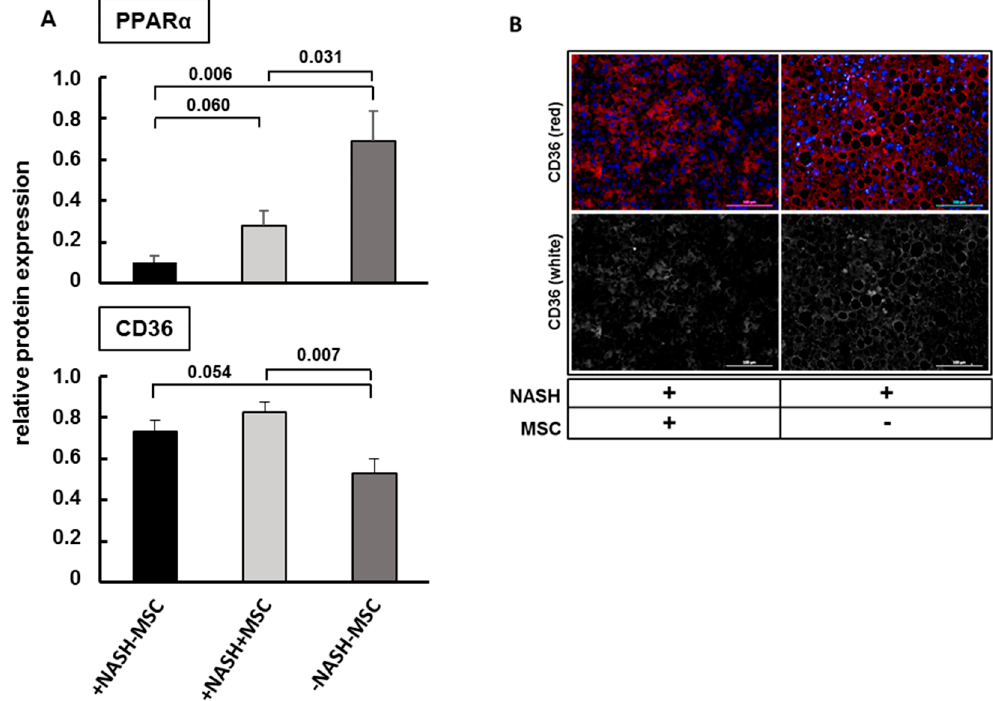
Figure 2. Expression of CD36 and PPAR α in MCD-treated mice with and without MSC application. ( A ) Upregulation of CD36 expression and downregulation of PPAR α in NASH livers and partial reversal by MSCs as shown by semiquantitative Western blot analysis of liver cytosolic extracts from 6 different animals in each group. Vinculin was used for normalization. Values represent means ± SEM and significant differences as indicated by the p -values over the horizontal lines were identified by applying the Student’s t -test for unpaired values; ( B ) fluorescent immunohistochemical detection of CD36 in representative liver slices of +NASH-MSC livers and after treatment with MSC (+NASH+MSC). Scale bar 100 μ m.